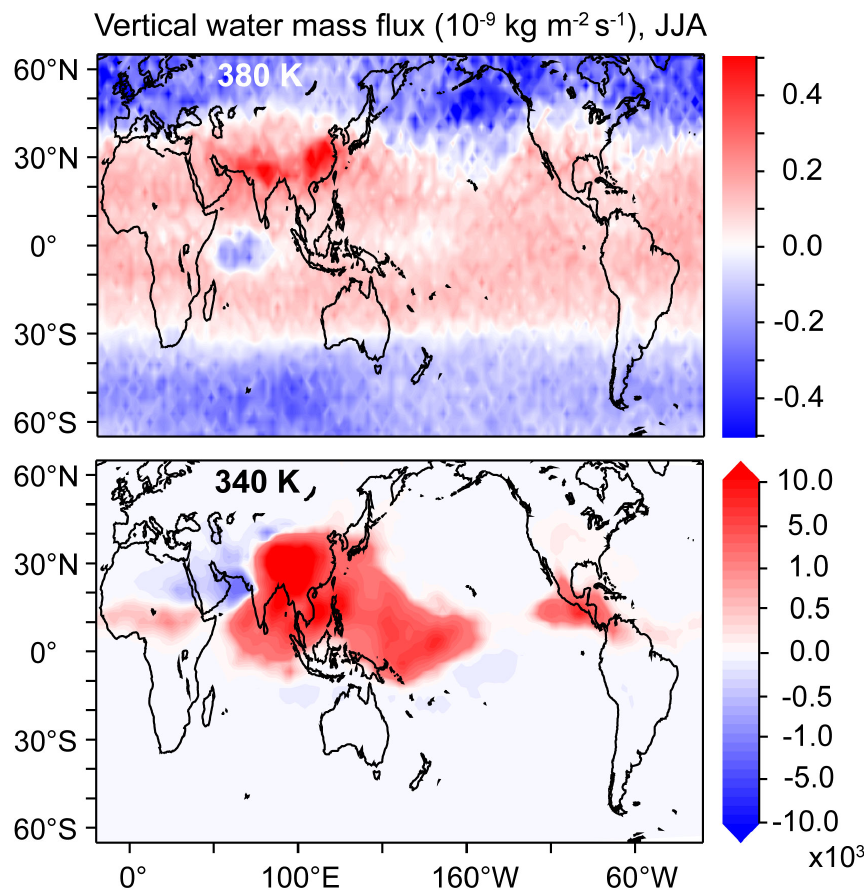
Fig. 49. Model calculated water mass fluxes (in all phases) across the 340 and 380K isentropes, averaged for the periods June–August 2002 and 2003; red is upward; note that the scale changes between the lower and upper panel (from Lelieveld et al., 2007, copyright 2007 by the European Geophysical Union, modified with